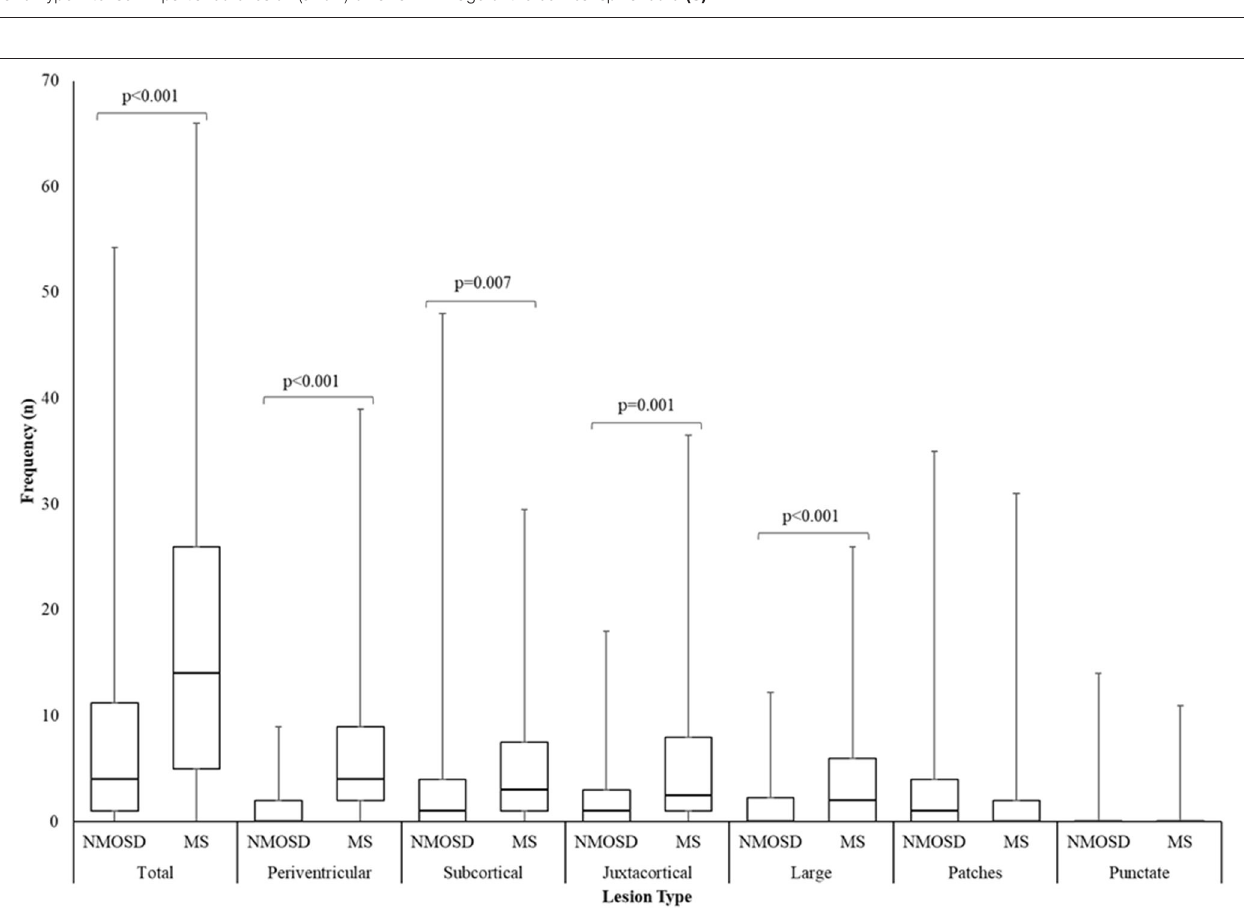
FIGURE 7 | Box and whisker plot of the number of T2 lesions seen in NMOSD and multiple sclerosis for the most numerous brain lesion types. Lesion counts were the highest number of unique lesions seen on an individual scan from all MRI per patient. Central bar indicates median, boxes show interquartile range and whiskers show